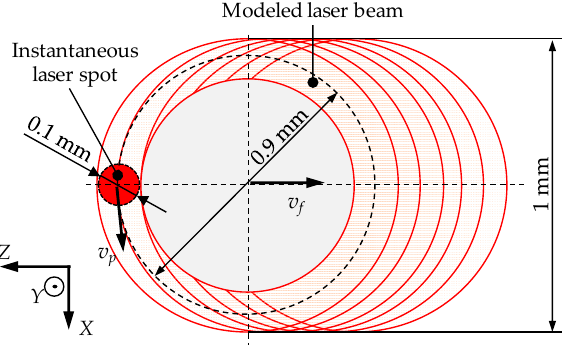
Figure 4. Wobble scanning technique employed for the welding operation.